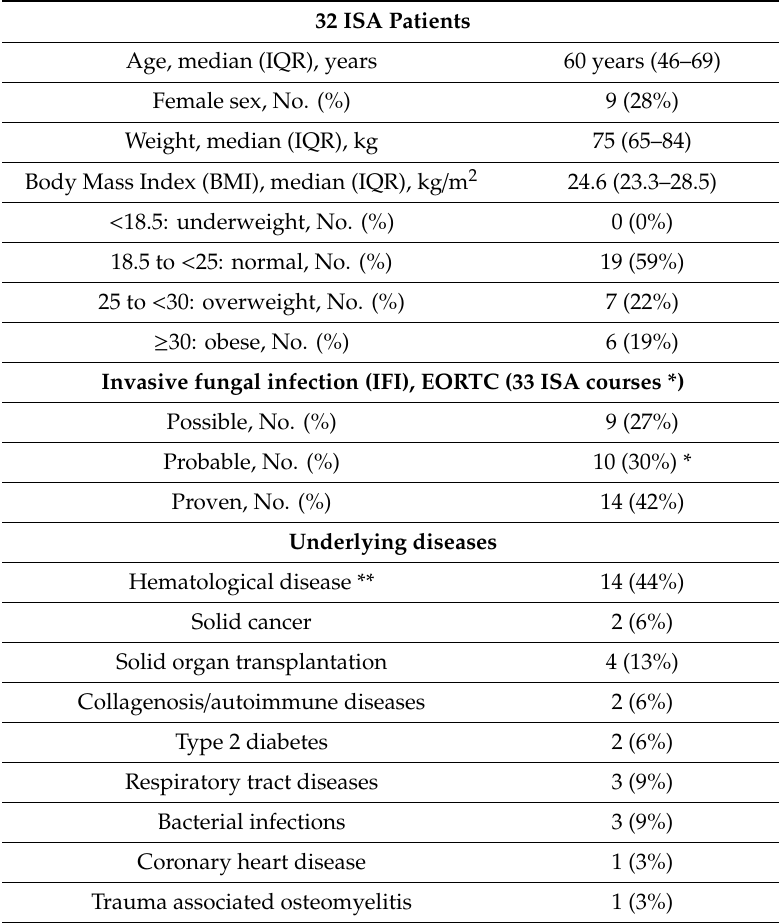
Table 1. Demographics of Isavuconazole (ISA) treated